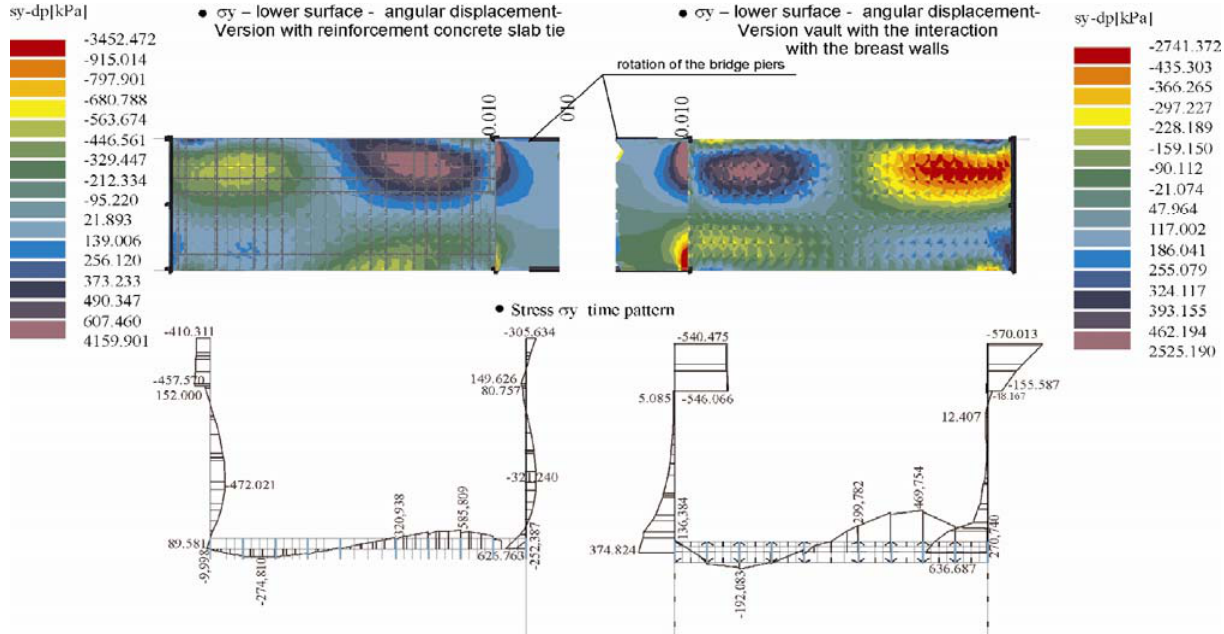
Fig 6. Transverse normal stress σ y time pattern of investigated